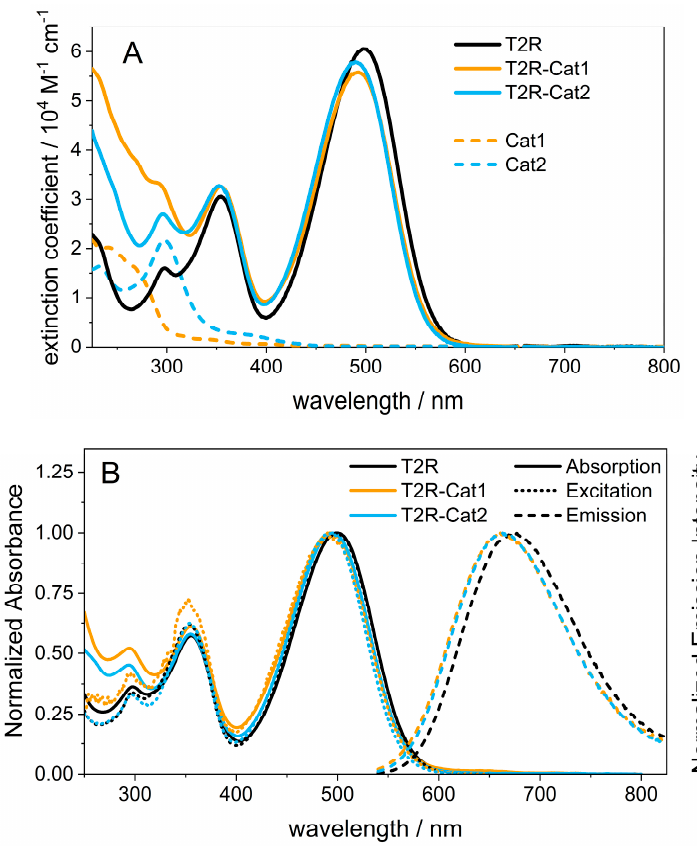
Figure 2. ( A ) UV-Vis absorption spectra of T2R, T2R-Cat1, T2R-Cat2, Cat1 and Cat2 recorded in acetonitrile. ( B ) Normalized absorption, emission and excitation spectra of T2R, T2R-Cat1 and T2R-Cat2 recorded in MeOH. The emission quantum yield was 0.25 (T2R), 0.02 (T2R-Cat1) and 0.08 (T2R-Cat2). Considering their targeted application for hydrogen production under aqueous conditions, the electronic properties of the dyads were further studied in methanol (MeOH), which is a protic solvent of higher polarity (E TN = 0.76) and viscosity ( η = 0.59 mPa ∙ s − 1 ) than ACN (E TN = 0.46 and η = 0.35 mPa ∙ s -1 ) [28,29]. The UV-Vis absorption spectra in MeOH (Supplementary Figures S2B and S3) are similar to those recorded in ACN. In particular, no significant shift of the ICT band is observed.